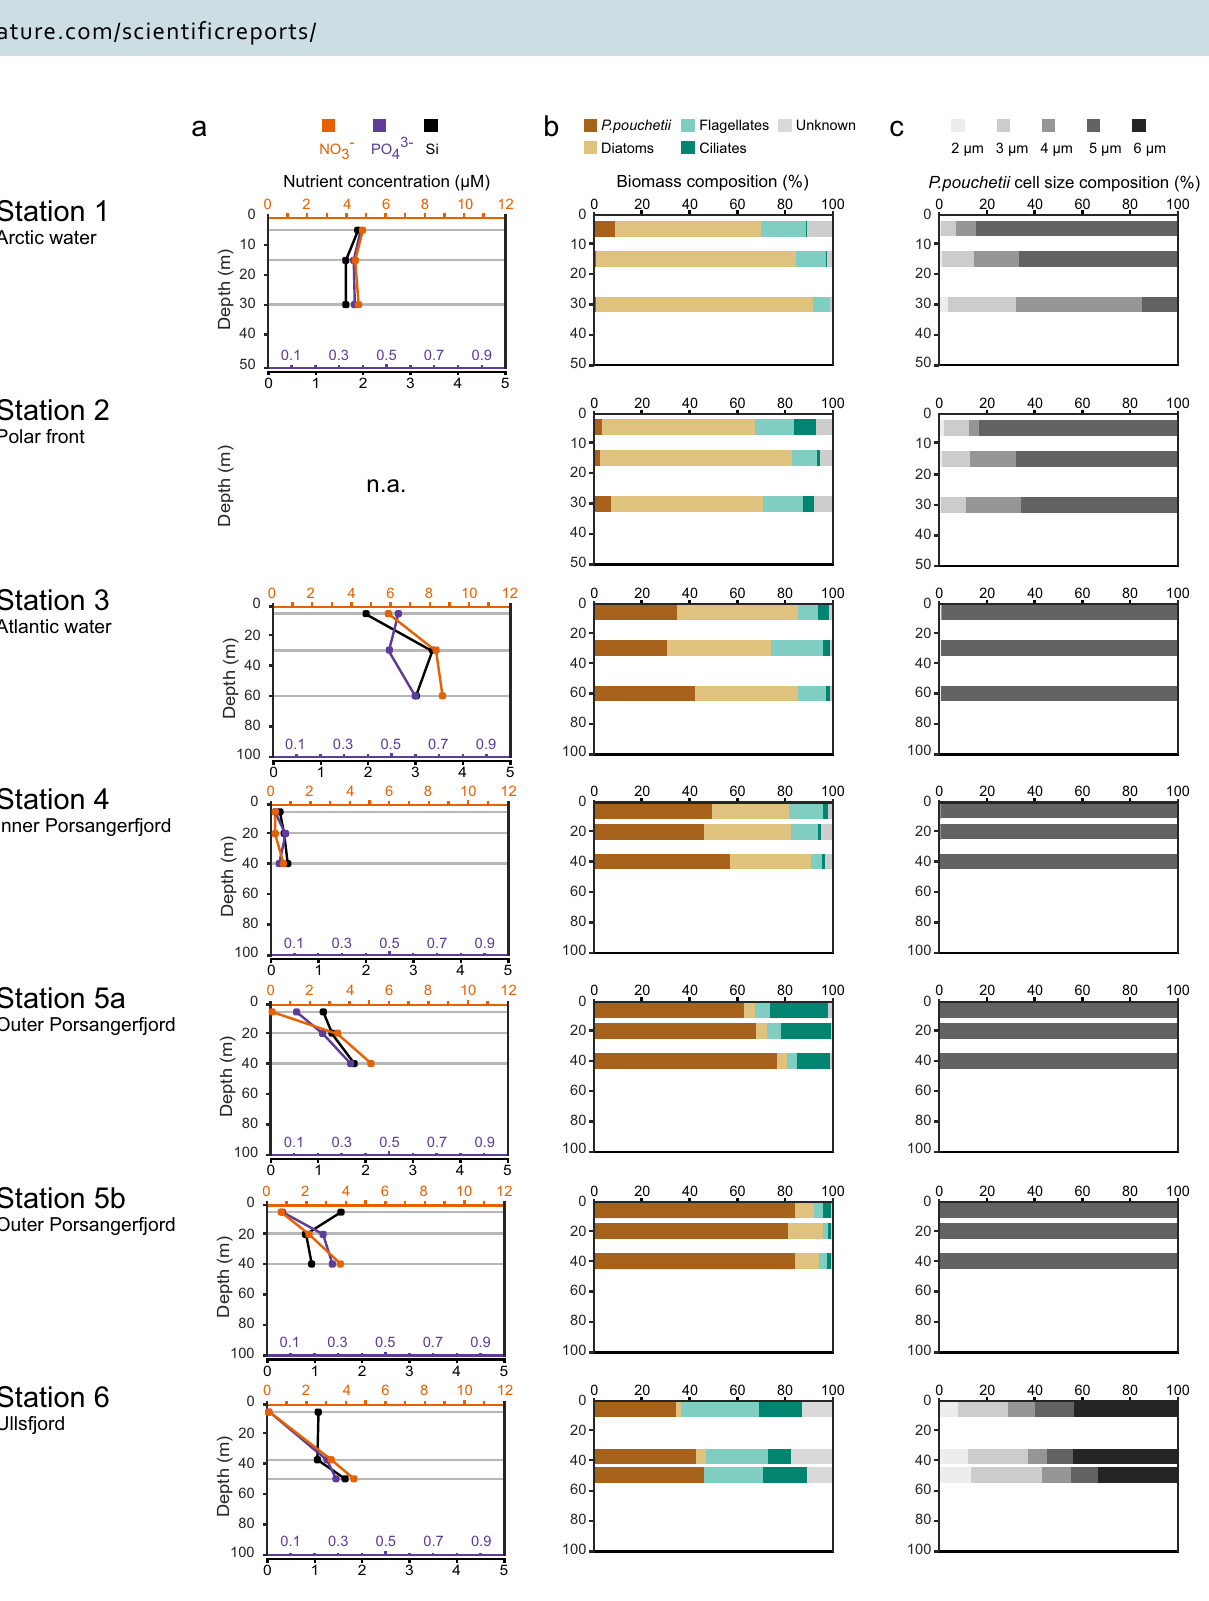
Figure 3. PHAEONIGMA cruise metadata of stations sampled along a transect in the Barents Sea (Station 1–3) and in North Norwegian fjords (Station 4–6). The geographic location of the cruise station is given in Fig. 5a. ( a ) Depth profiles of dissolved inorganic nutrient concentrations (µmol L −1 ) of nitrate (orange), phosphate (violet), and silicate (black). ( b ) Biomass proportion (% mg C m −3 ) of phytoplankton taxa classified as ’ Phaeocystis pouchetii ’, ’diatoms’, ’flagellates’, ’ciliates’, and ’unknown’. ( c ) Biomass proportion (% mg C m −3 ) of different cell sizes of P. pouchetii ranging from 2 µm (light grey) to 6 µm (dark grey). Phytoplankton community characteristics were determined by microscopy (for absolute numbers see Supplementary Table S7). Grey horizontal lines represent the sampling depths above, at and below the Chl a maximum for metabolite profiling. n.a. not